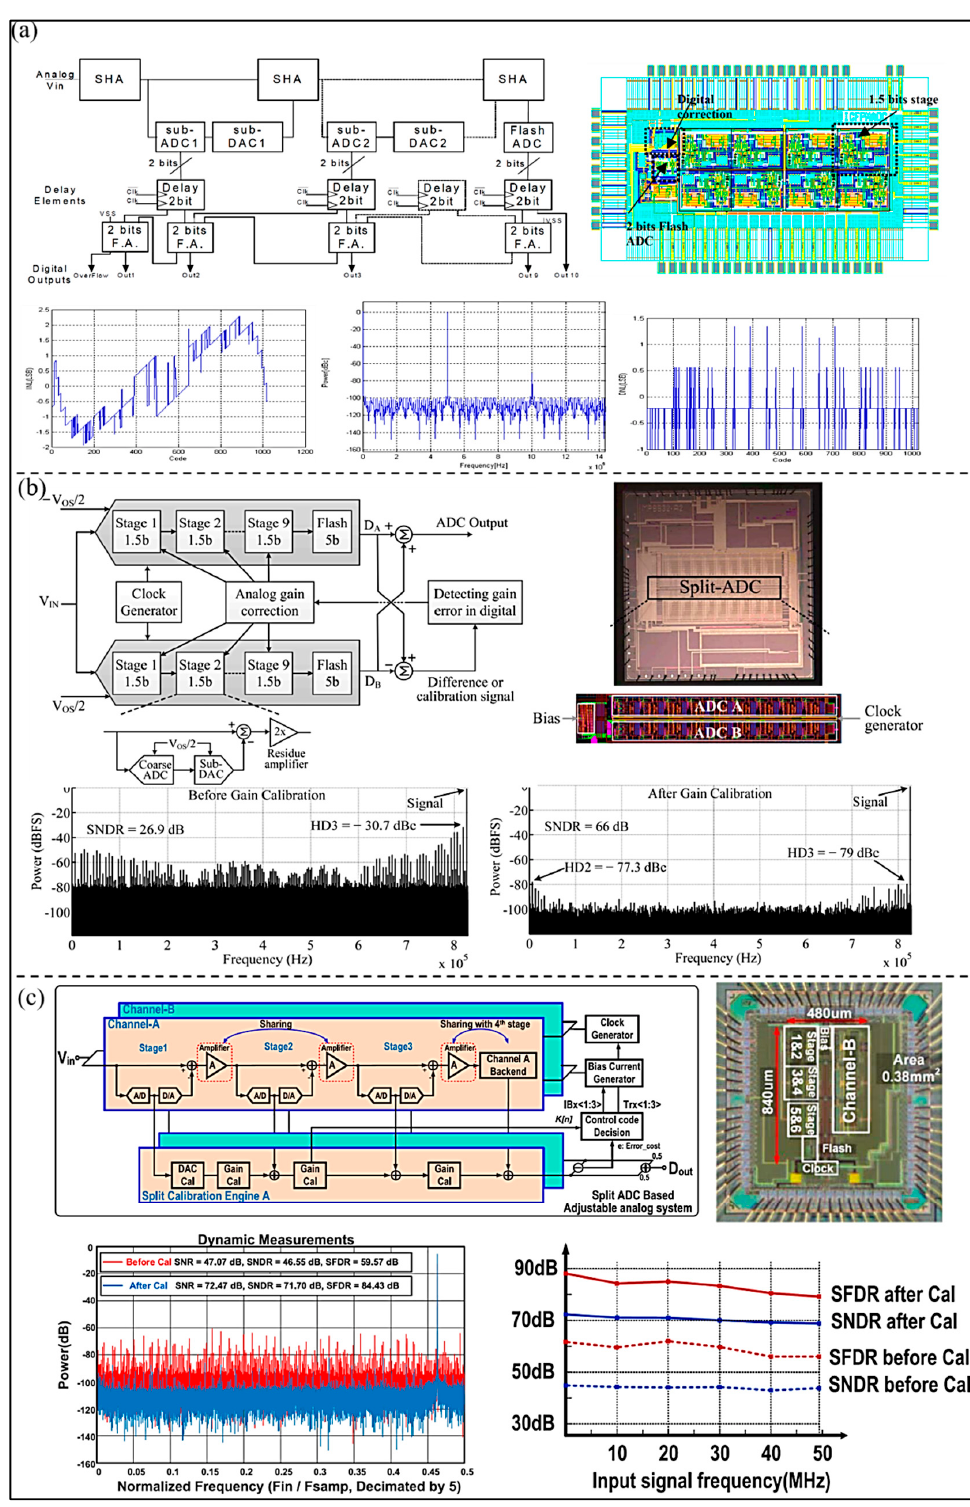
Figure 14. ( a ) Block diagram, layout, and measured results of the proposed ADC. (Reprinted from [58], Copyright 2002, with permission from IEEE); ( b ) Structure of the implemented pipelined split-ADC, die photograph, and experimental results. (Reprinted from [59], Copyright 2018, with permission from IEEE); ( c ) Block diagram and chip micrograph of the split-pipelined ADC with digital calibration and the measured result. (Reprinted from [60], Copyright 2018, with permission from